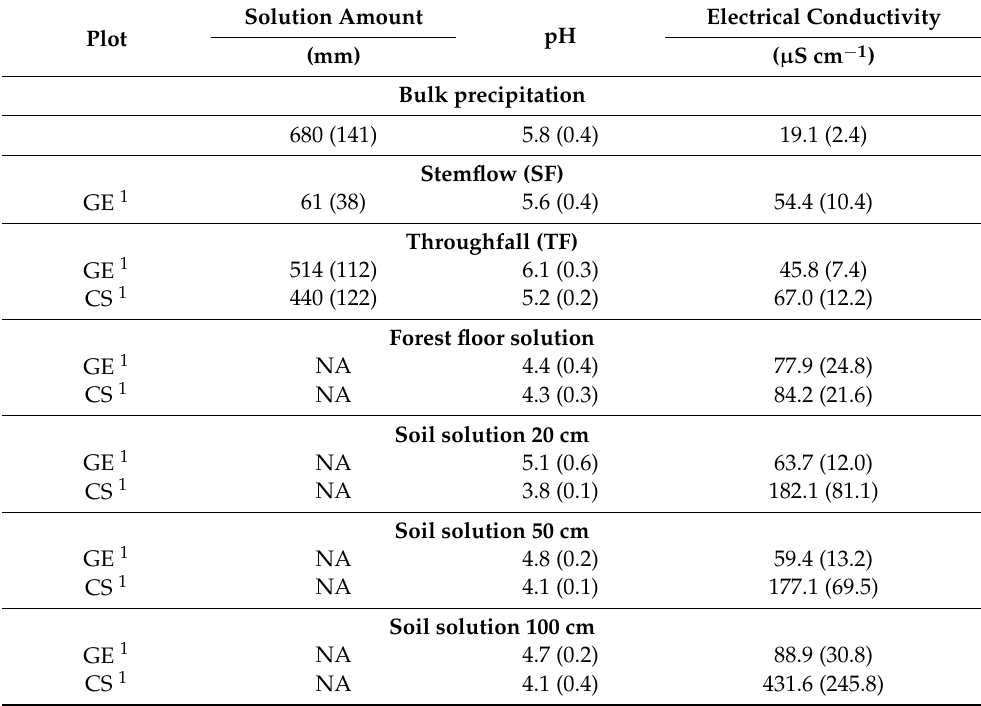
Table 3. Solution data (amount, pH, electrical conductivity) of bulk precipitation, stemflow (GE) and throughfall (GE and CS) as well as seepage water of forest floor and mineral soil (20 cm, 50 cm and 100 cm depth) at the plot-pair GE/CS ICP between 2001 and 2018. The site was observed in the framework of the ICP Forests Intensive Monitoring Programme (Level-II; ThüringenForst). GE: Groups of European beech within stands of Norway spruce and Scots pine (CS) near Hummelshain (Thuringia, Central Germany).